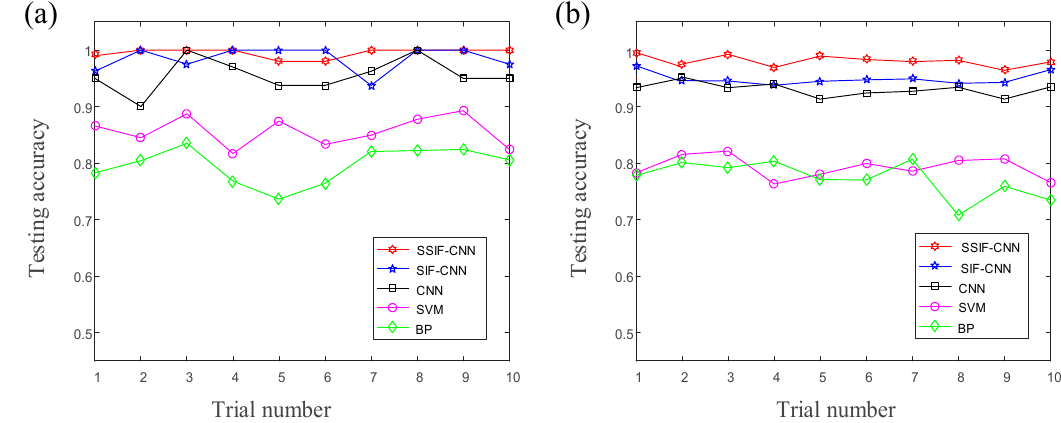
Figure 15. The accuracies of the ten trials: ( a ) training accuracies, and ( b ) testing accuracies.